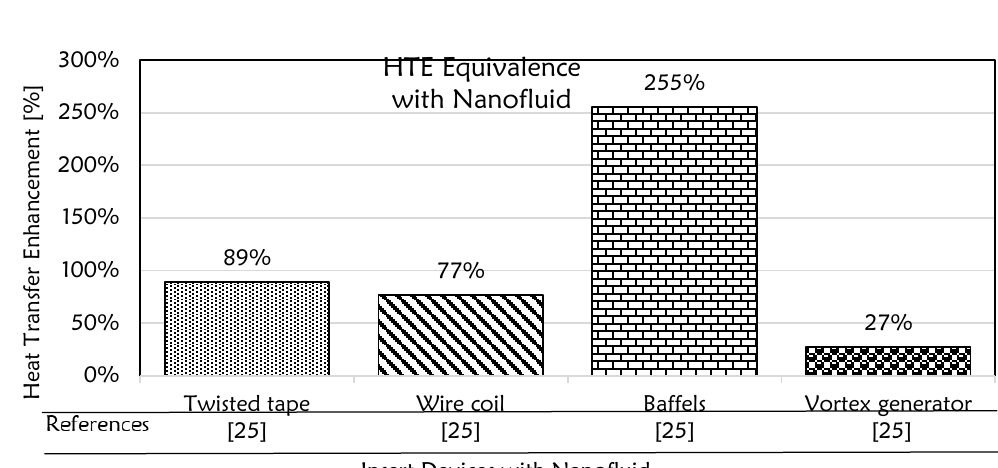
Figure 19: The equivalence heat transfer enhancement of various insert devices with nanofluid compared to identical insert devices without nanofluids.